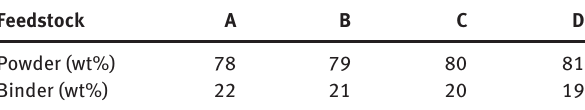
Table 2 The characteristics of the feedstocks.